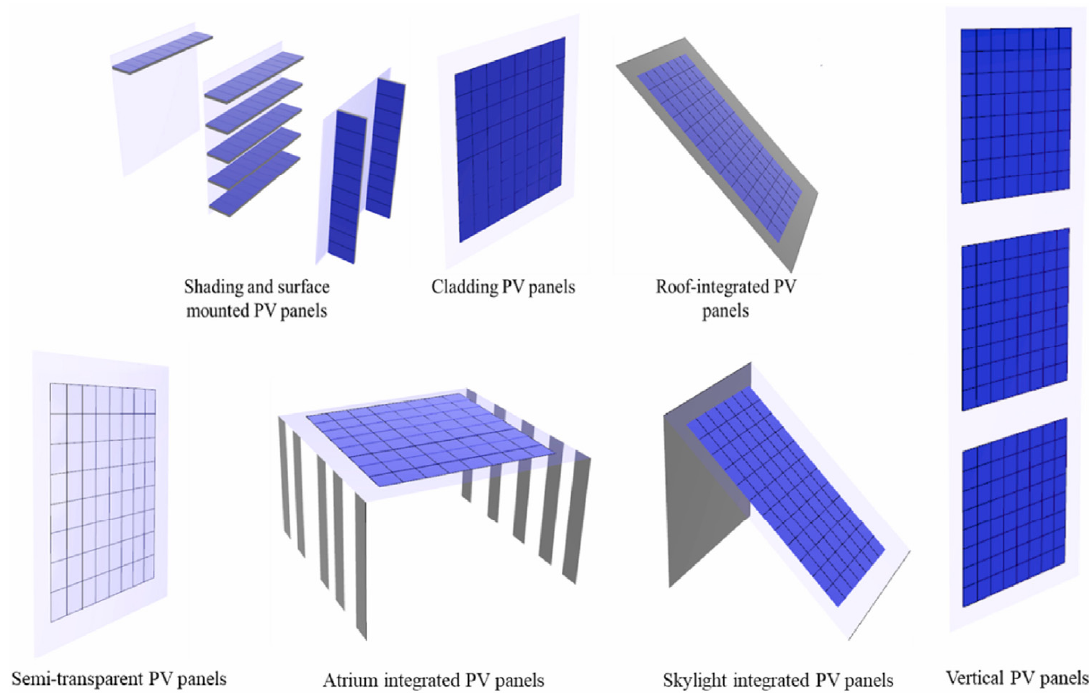
Figure 1. PV-integrated building envelope [8].